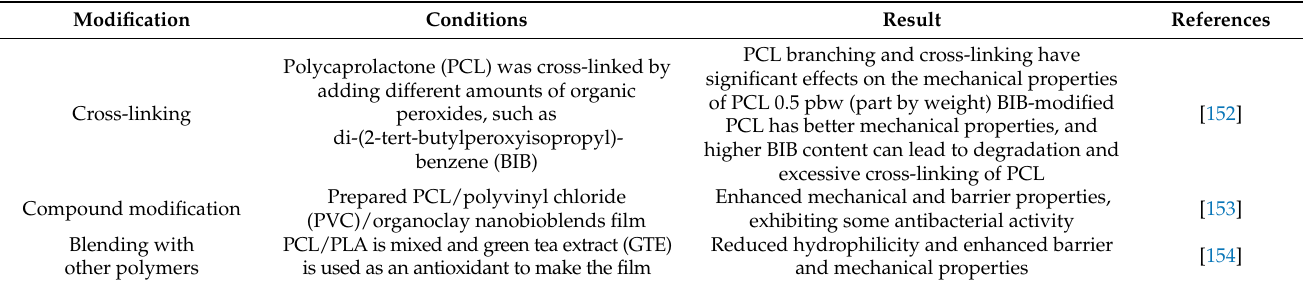
Table 9. The different modifications of PCL film materials.